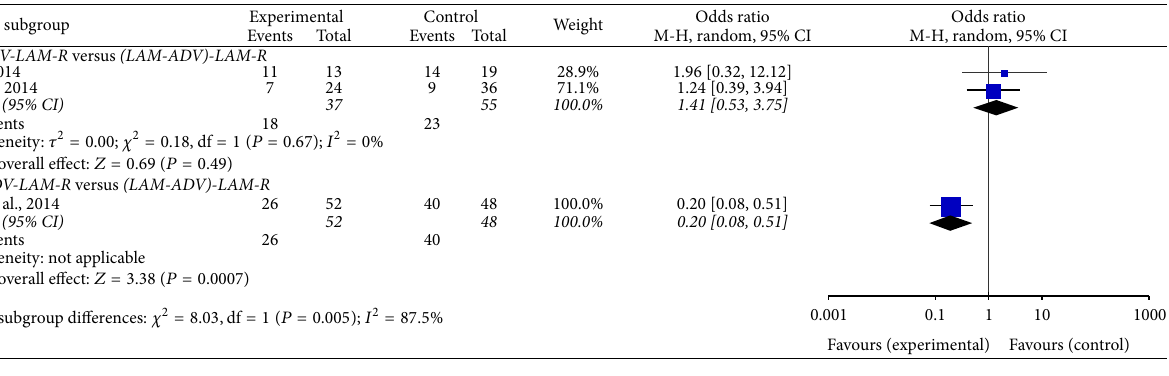
Figure 1: Forest plot of direct meta-analysis of undetectable HBV DNA rate. (a) 24 weeks; (b) 48 weeks; (c) 96 weeks.